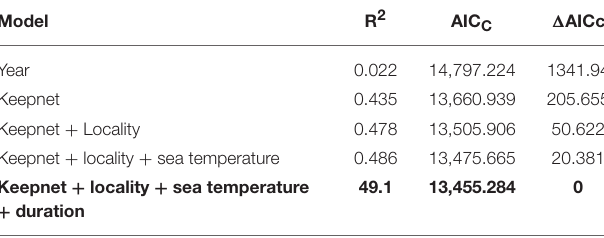
TABLE 6 | Predictive model selection using the corrected Akaike’s information criterion for mortality rate (AICc).